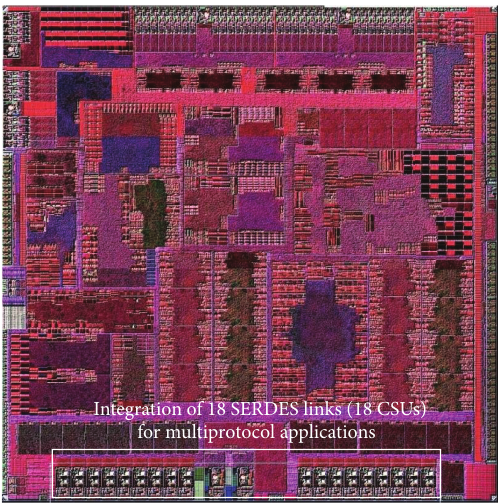
Figure 8: Physical view of the single-chip multirate/multiprotocol PHY system-on-chip device.